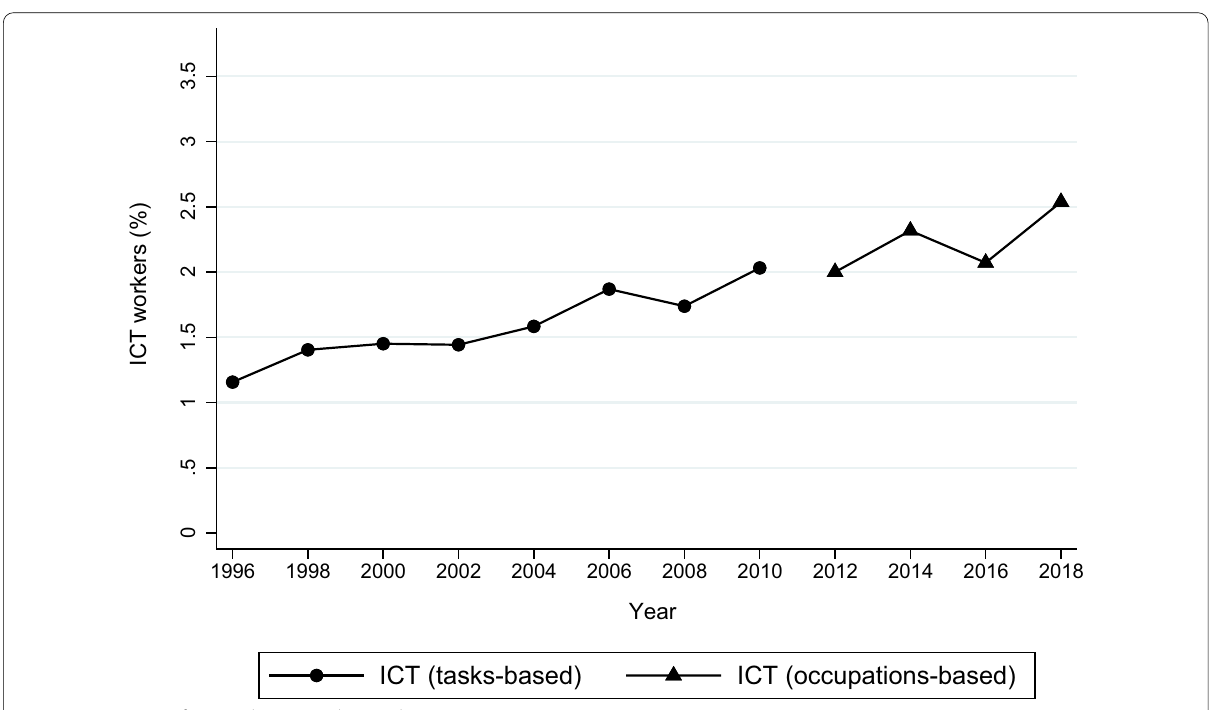
Fig. 2 Percentage of ICT workers according to the two